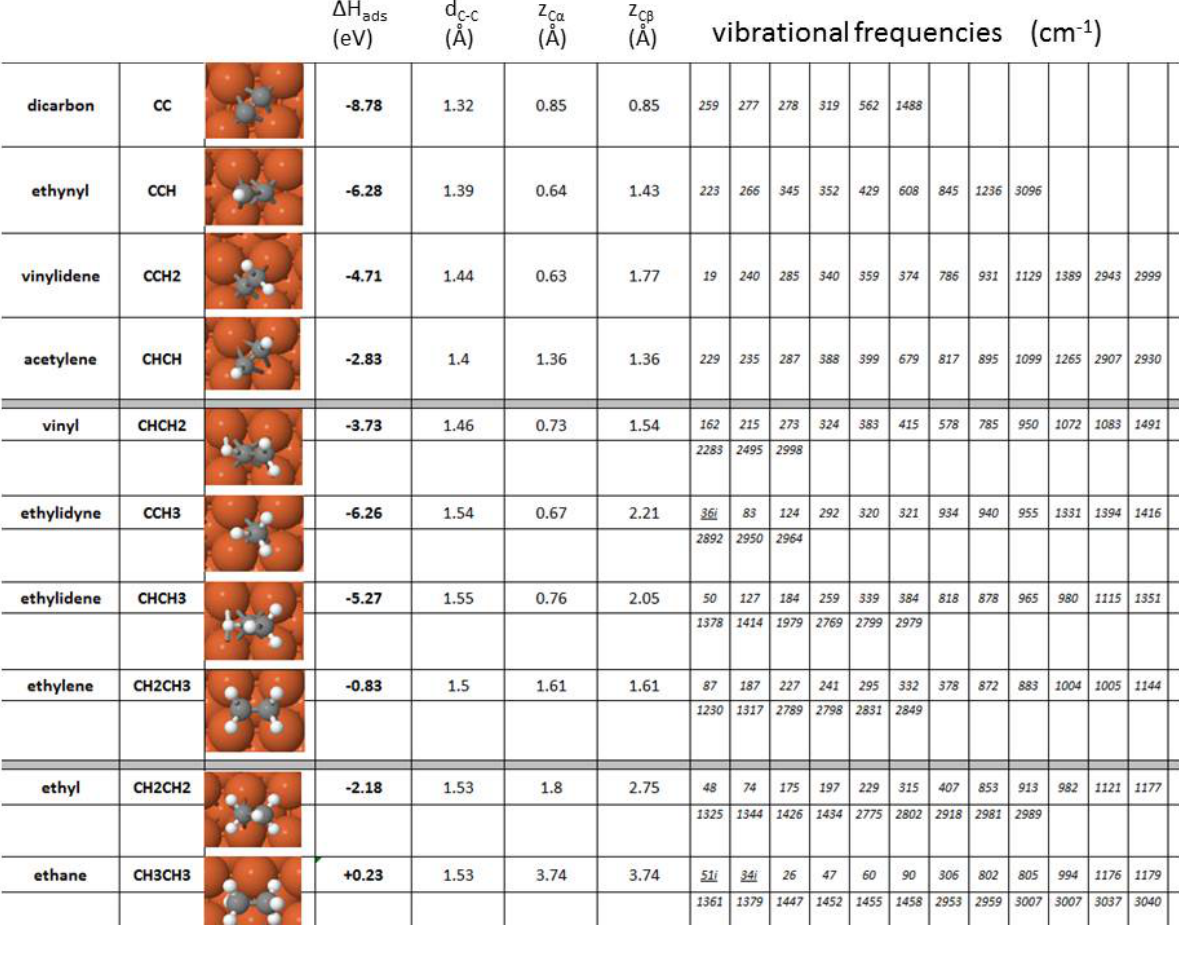
Table 1. Lowest energy configuration for all intermediates in acetylene, ethylene and ethane formation and decomposition reactions, along with heats of adsorption, specific structural parameters and vibrational